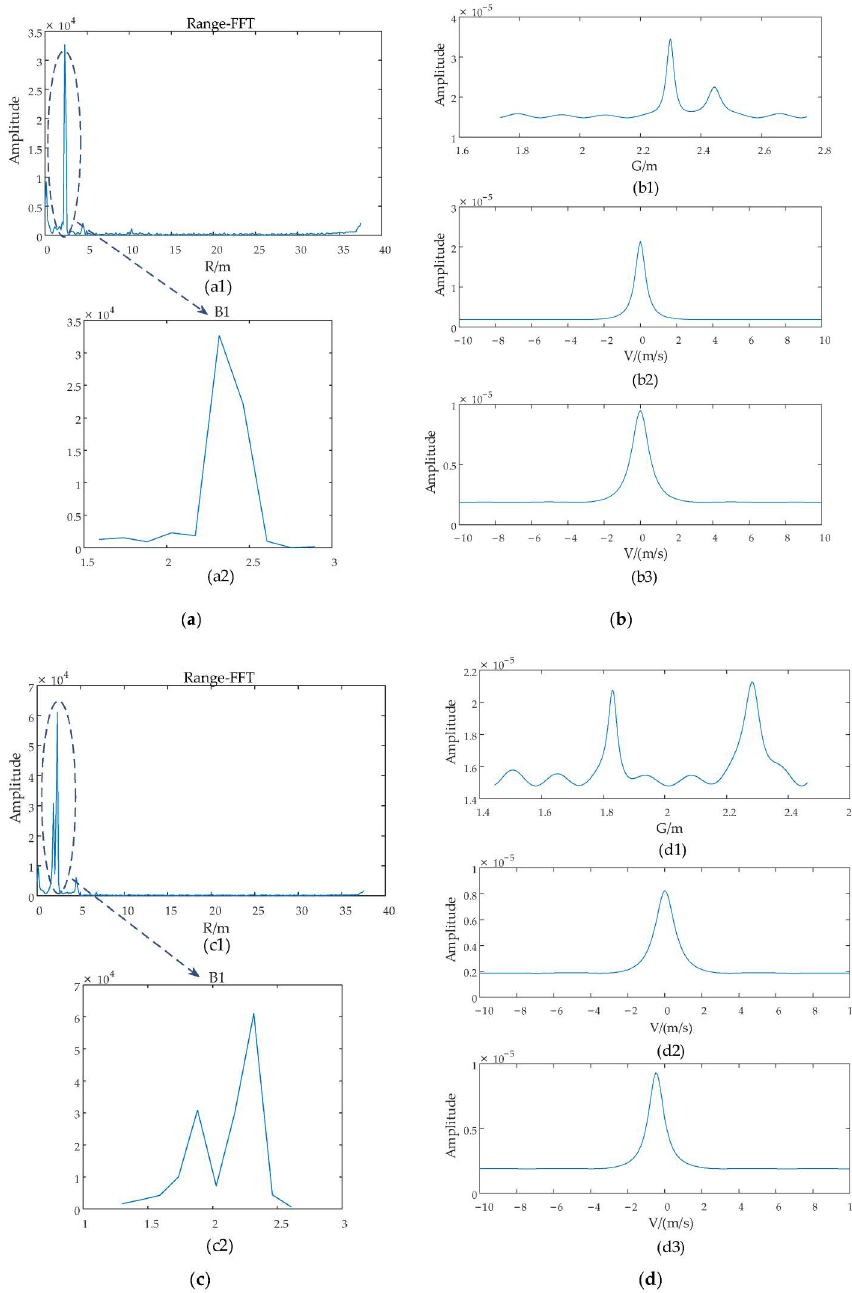
Figure 12. The estimation process of G and V . ( a ) is the targets-located blocks selection of experiment 1. ( b ) is the result of G and V of experiment 1. ( c ) is the targets-located blocks selection of experiment 2. ( d ) is the result of G and V of experiment 2. Table 3. The estimated results of experiment 1 and experiment 2. Target